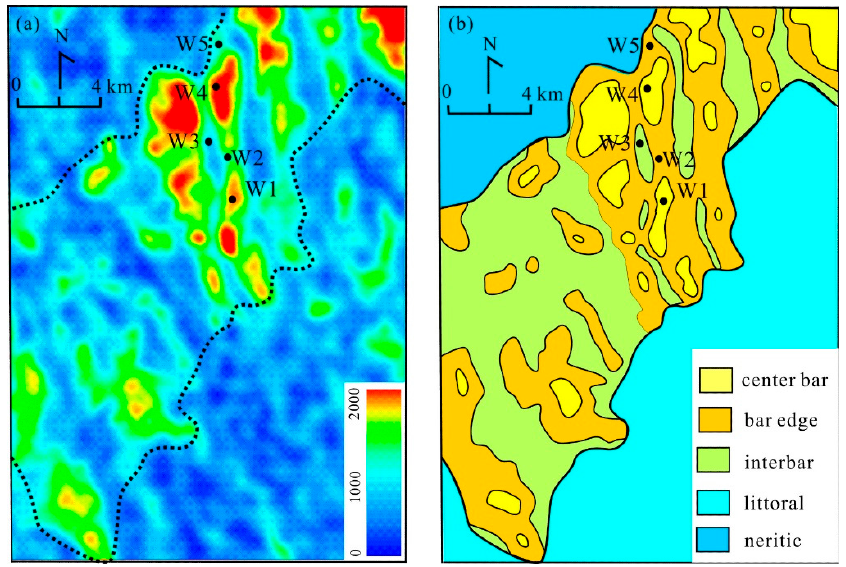
Figure 12. Sandbar sedimentary microfacies analysis map. ( a ) Energy attenuation attribute (EAA) map, ( b ) sedimentary microfacies distribution map.